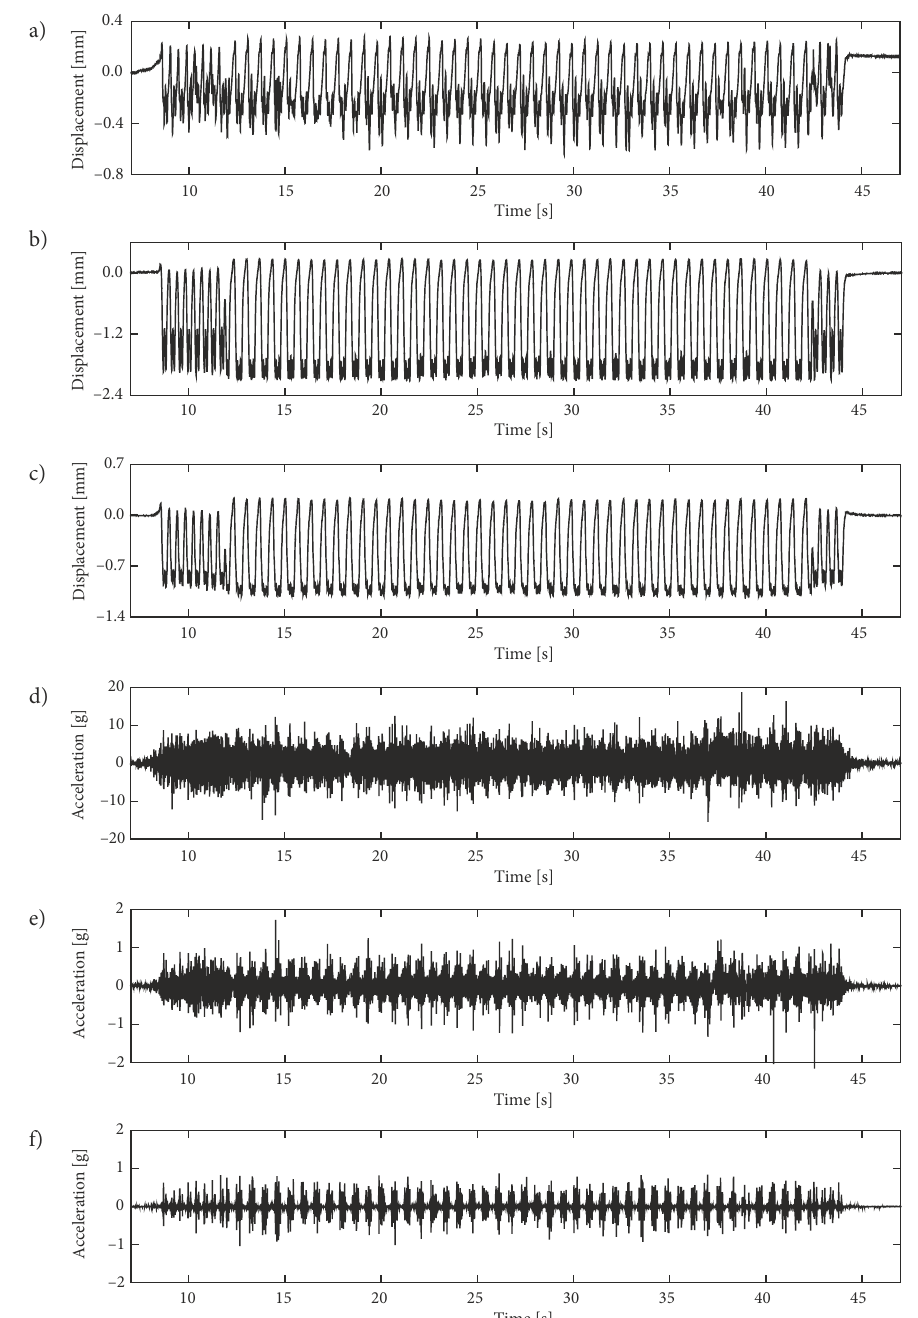
Figure 9. Time histories of the track vibration: a – rail lateral displacement; b – rail vertical displacement; c – sleeper vertical displacement; d – rail vertical acceleration; e – sleeper vertical acceleration; f – ballast vertical